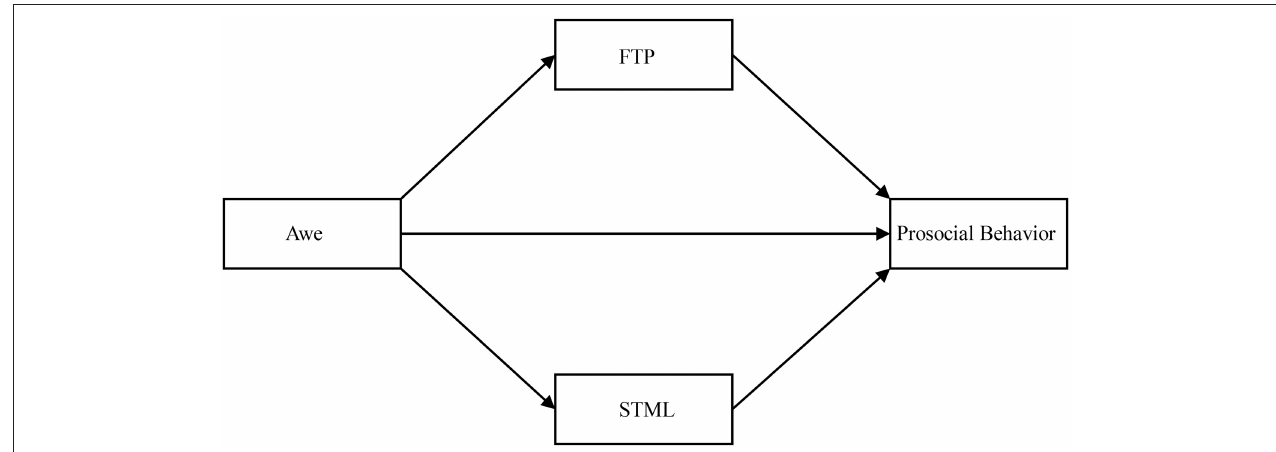
FIGURE 1 | Theoretical model. FTP, future time perspective; SML, Self-transcendence Meaning of